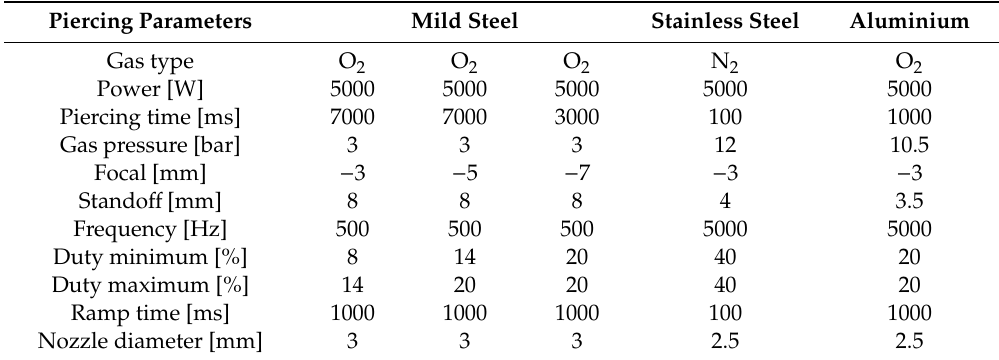
Table 1. Piercing parameters for mild steel 20 mm thick and stainless steel and aluminum 10 mm thick. Piercing Parameters Mild Steel Stainless Steel